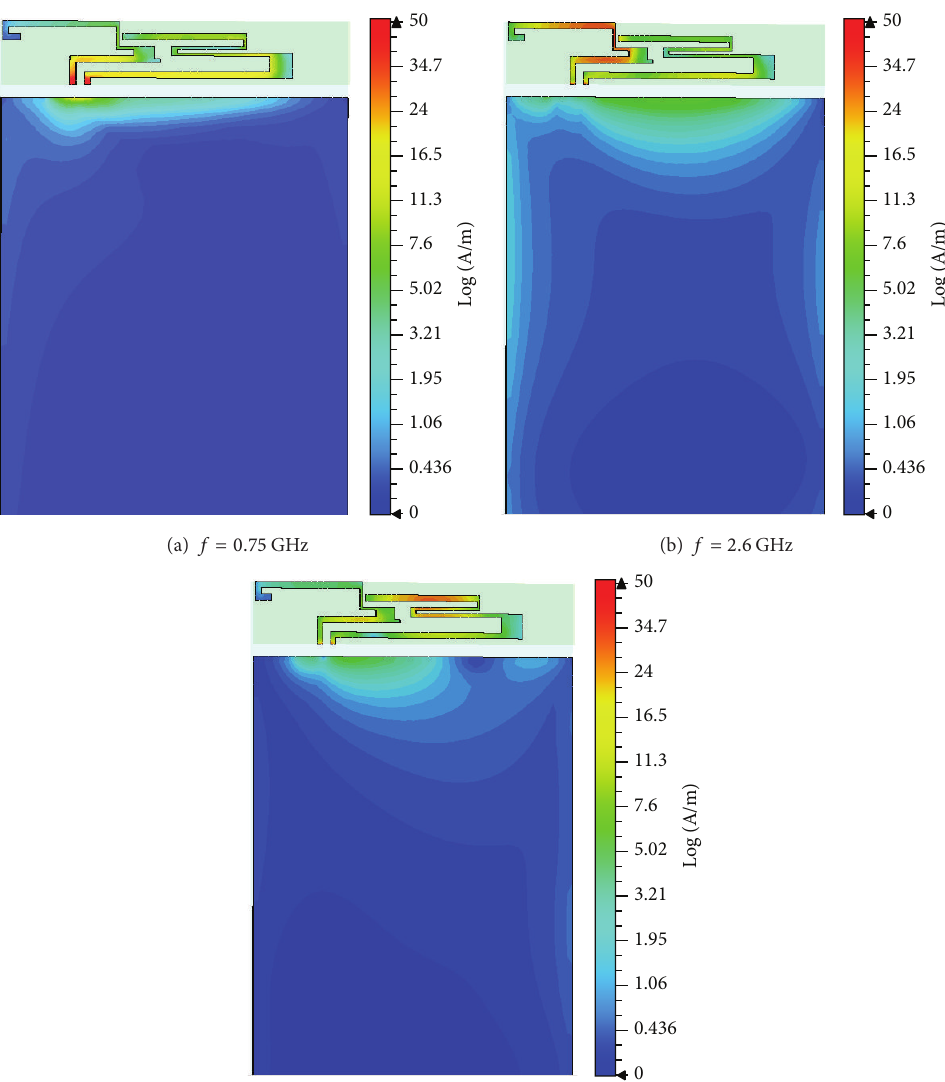
Figure 9: Surface current distributions on the proposed antenna at (a) 0.75 GHz; (b) 2.6 GHz; and (c) 3.5